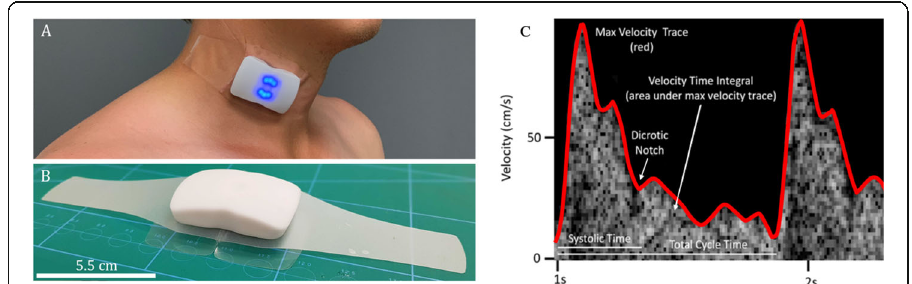
Fig. 1 The wireless Doppler ultrasound patch. a Wireless, hands-free Doppler patch placed over common carotid artery of a healthy volunteer. b Scaled image of the Doppler patch. c Metrics obtained from wearable